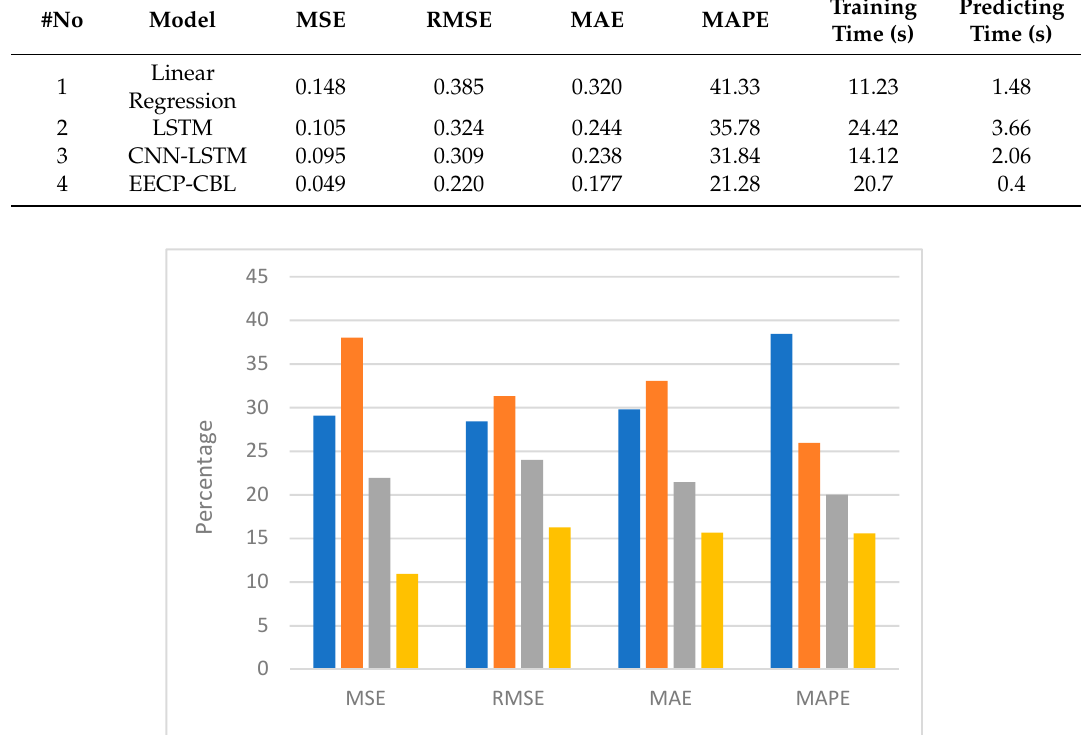
Figure 3. The average percentages of experimental methods over four datasets.